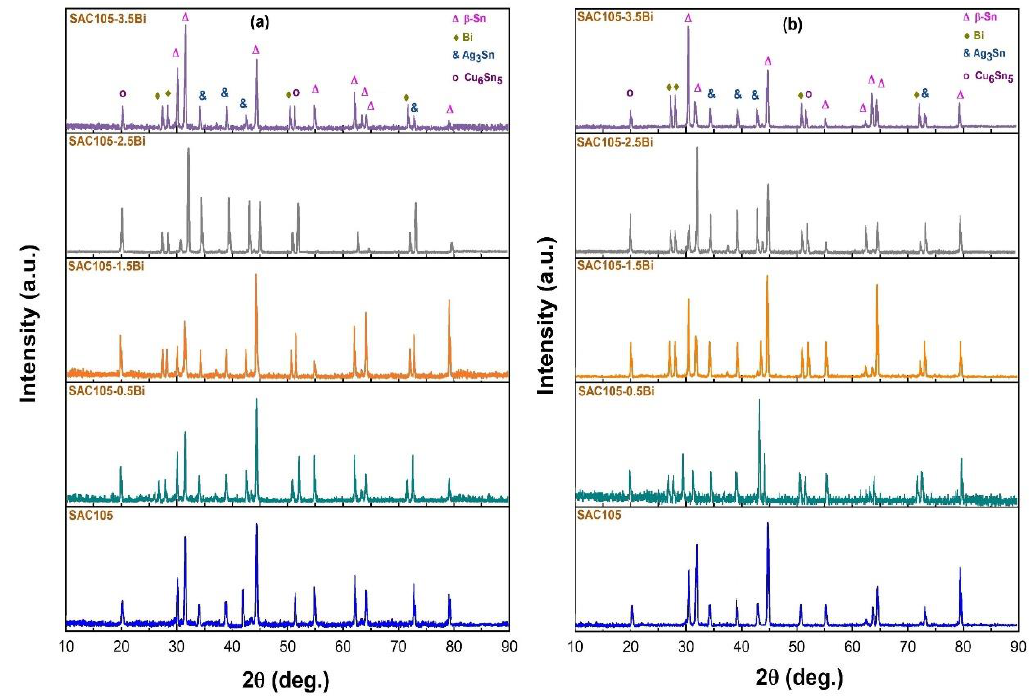
Figure 12. Representative XRD patterns of the investigated solder alloys aged at: ( a ) 353 K and ( b ) 413 K. Table 2. The calculated crystalline lattice parameters a , c , c/a ratio, and the unit cell volume V for β -Sn matrix at different aging temperatures and various bismuth